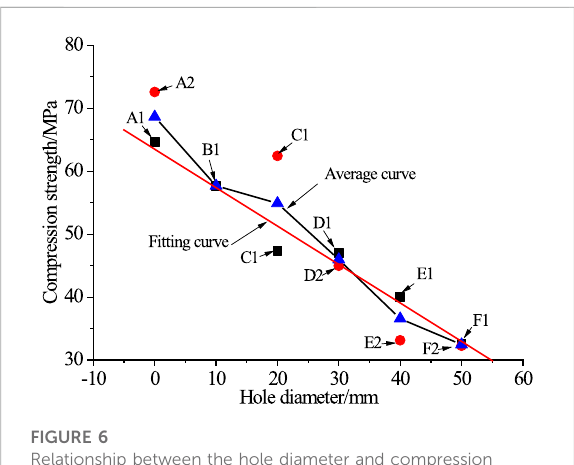
FIGURE 5 Stress – strain curves of uniaxial compression on specimens.